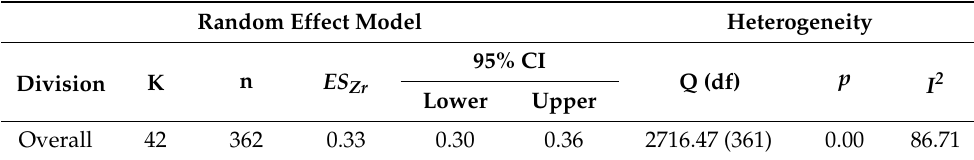
Table 3. Overall effect size